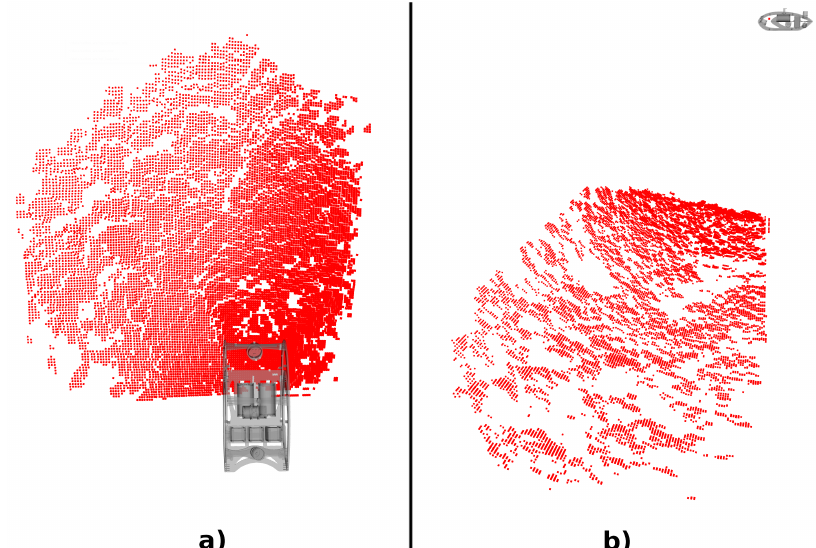
Figure 1. Illustration of a point cloud obtained from a single ping of the Echoscope 3D, where ( a ) is a top view and ( b ) a side view of the same scan. The scan is composed of a matrix of 128 × 128 points, represented in red. The robot model, in grey, represents the scan acquisition